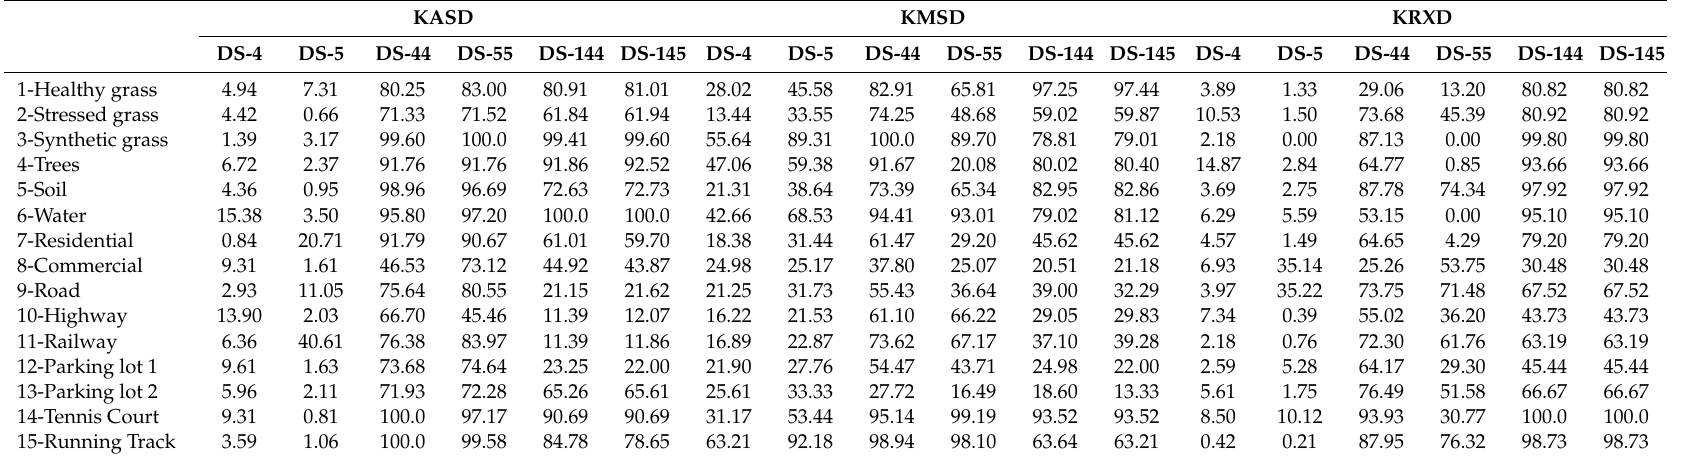
Table 7. Class specific accuracies of Kernel ASD (KASD), Kernel MSD (KMSD), and Kernel RXD (KRXD) with various band